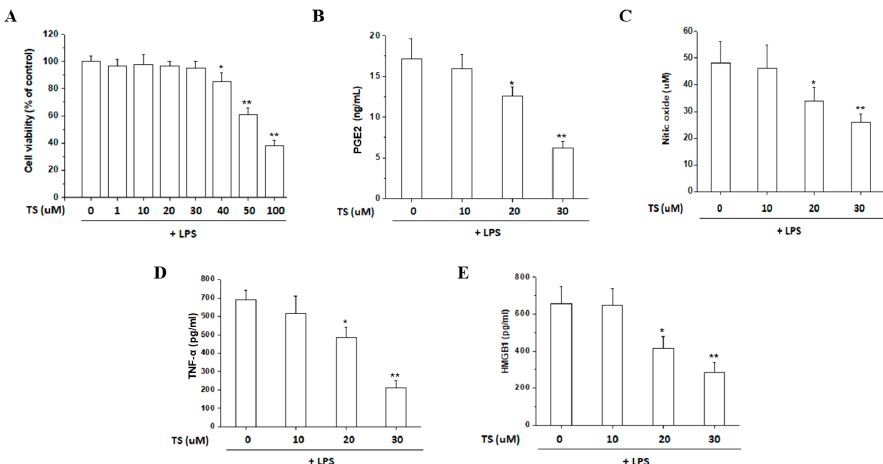
Figure 4. Effect of TS on inflammatory mediators in LPS-stimulated peritoneal macrophages. Peritoneal macrophages were isolated, pretreated with TS at the indicated concentrations for 1 h and then stimulated with LPS (100 ng/mL) for 24 h. ( A ) Viability of the cells were measured by 3-(4,5-dimethylthiazol-2-yl)-2,5-diphenyltetrazolium bromide (MTT) assay. The culture medium was also collected and subjected to an NO assay ( B ) and ELISA to measure the concentration of PGE2 ( C ) TNF- α ( D ) and HMGB1 ( E ). * p < 0.05, ** p < 0.01 vs. LPS-treated sample. All experiments were performed in triplicate.